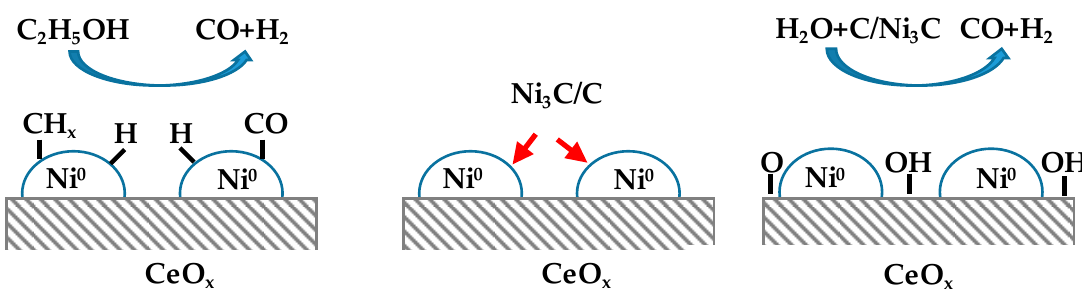
Figure 1. Mechanism of coke formation and removal on a Ni / CeO x catalyst during ethanol steam reforming (ESR) [51].